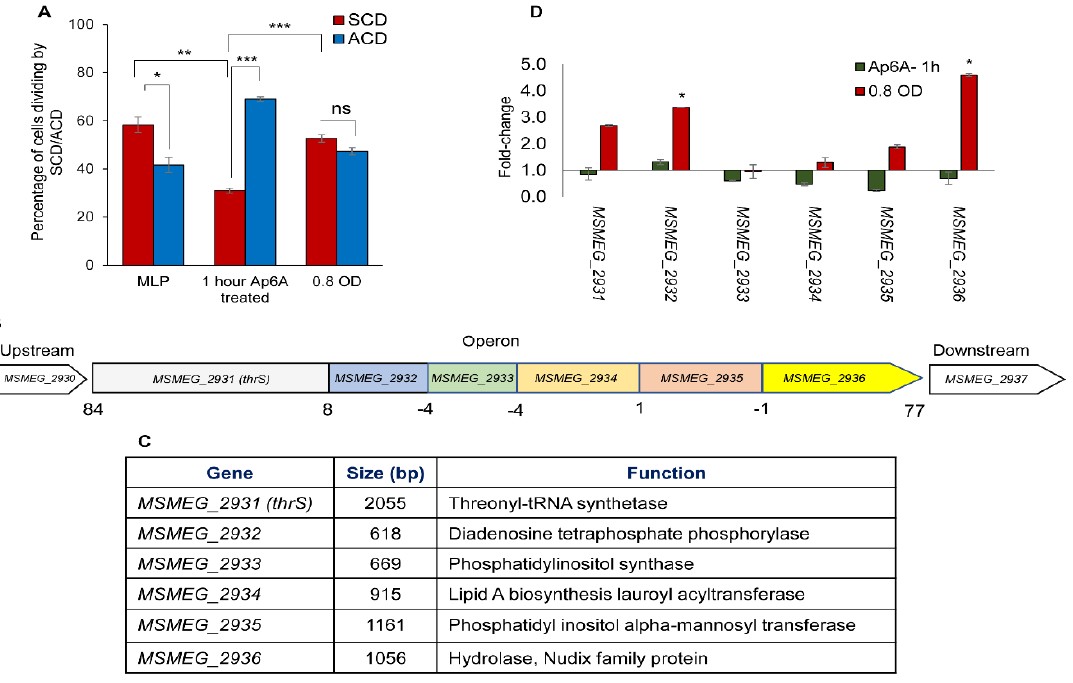
Figure 6. Proportion of the cells undergoing ACD:SCD in M. smegmatis MLP, Ap 6 A-exposed and 0.8 OD cultures, operon of six Ap n A/cell division related genes, and the fold-change in their expression. ( A ) Percentage of cells dividing by ACD/SCD in the cells from MLP, 166 pM Ap 6 A exposed cells for 1 h and 0.8 OD cultures ( n = 300). The data shown are for biological triplicates, represented with mean values ± s.d. p < 0.05 *, p < 0.01 **, p < 0.001 ***, ns—no significance via two-tailed t -test). ( B ) MSMEG_2931 ( thrS )— MSMEG_2936 operon. MSMEG_2931 ( thrS )— MSMEG_2936 genes in the operon are shown in color boxes. The genes upstream and downstream of the operon are shown in white. The arrowhead indicates the transcription direction. The numbers appearing below the genes indicate the intergenic distance between two adjacent genes, where the negative number indicates the overlapping genes. The size of each boxes showing a gene in the operon are virtual representation of the gene size (not to scale) and color code for each box is random. ( C ) Genes, size (bp), and their function in Msm . ( D ) Fold-change in the expression of MSMEG_2931 , MSMEG_2932 , MSMEG_2933 , MSMSEG_2934 , MSMSEG_2935 , and MSMEG_2936 after 1 h exposure of MLP cells to Ap 6 A and from 0.8 OD cells. The real-time PCR data shown are from biological duplicate and represented with mean values ± s.d. Statistical analysis was performed using unpaired student’s t -test where asterisk (*) indicates p -value ≤ 0.05.